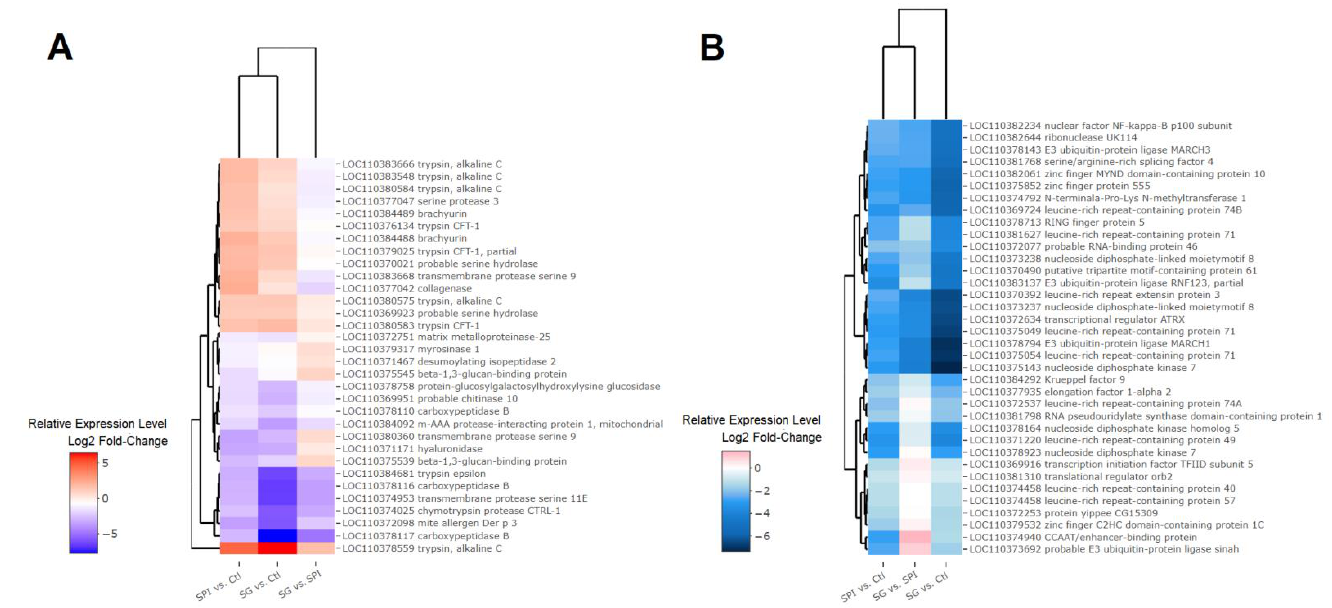
Figure 3. Heatmap and clustering of differentially expressed genes (Log2-FoldChange values >1 or < −1 and p -adjusted <0.05) encoding digestive enzymes ( A ) and regulatory functions ( B ) in the gut of H. armigera after exposure to SPIs (SPI vs. Ctl). The transcriptional profile of the second generation were compared with larvae from the first generation fed with and without SPIs (SG vs. SPI and SG vs. Ctl, respectively).